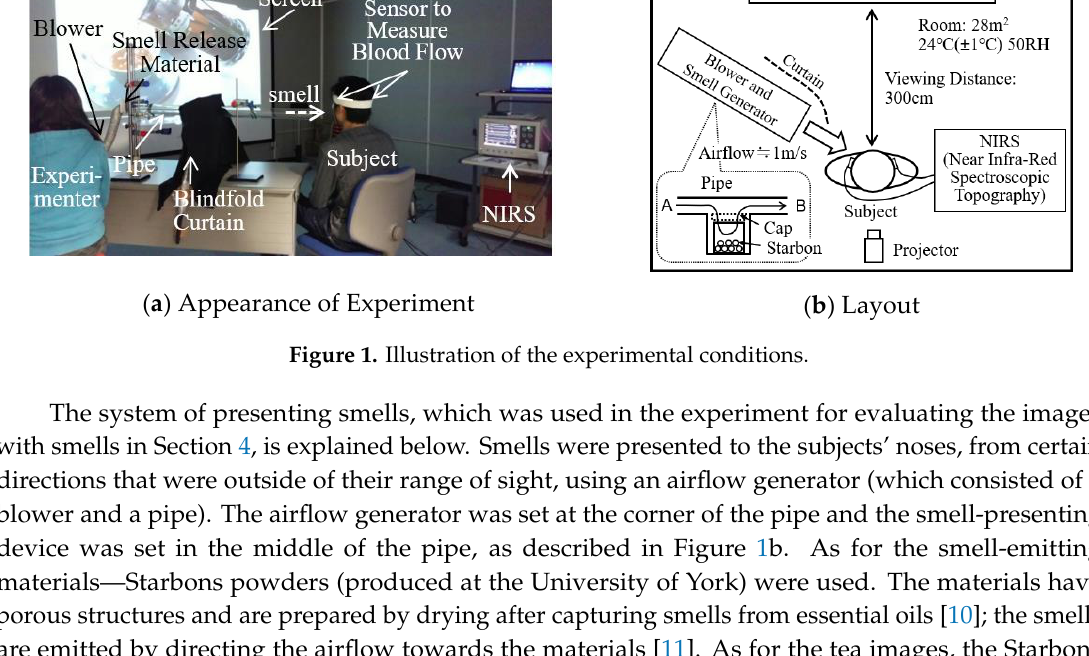
Figure 1. Illustration of the experimental conditions.